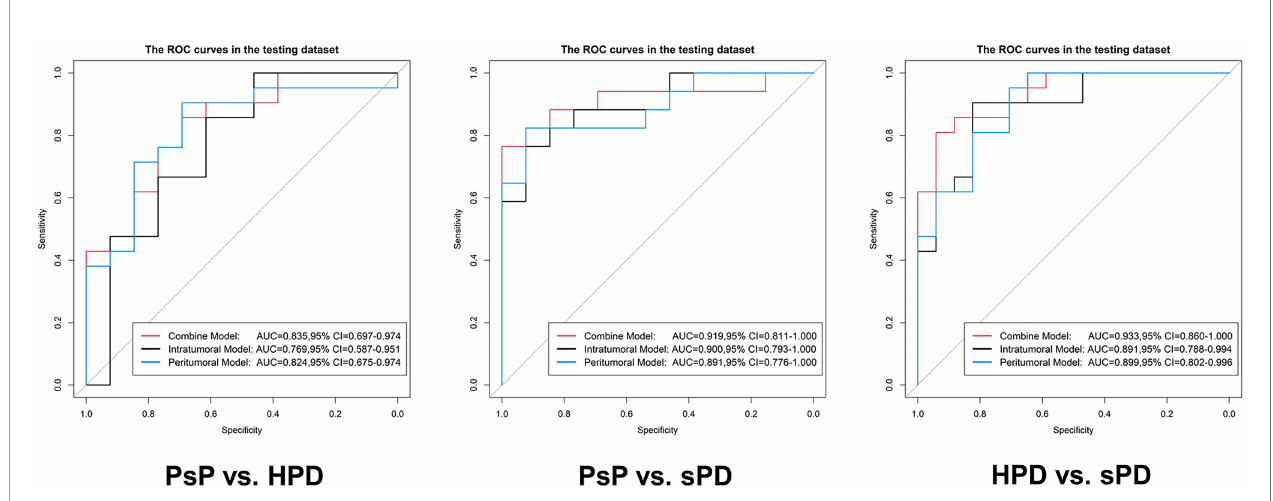
FIGURE 4 | Evaluation of the predictive performance of the radiomics signatures in the testing datasets. In each ROC, the black curve is the ROC of the intratumoral model, the blue curve is the ROC of the peritumoral model, and the red curve is the ROC of the combine